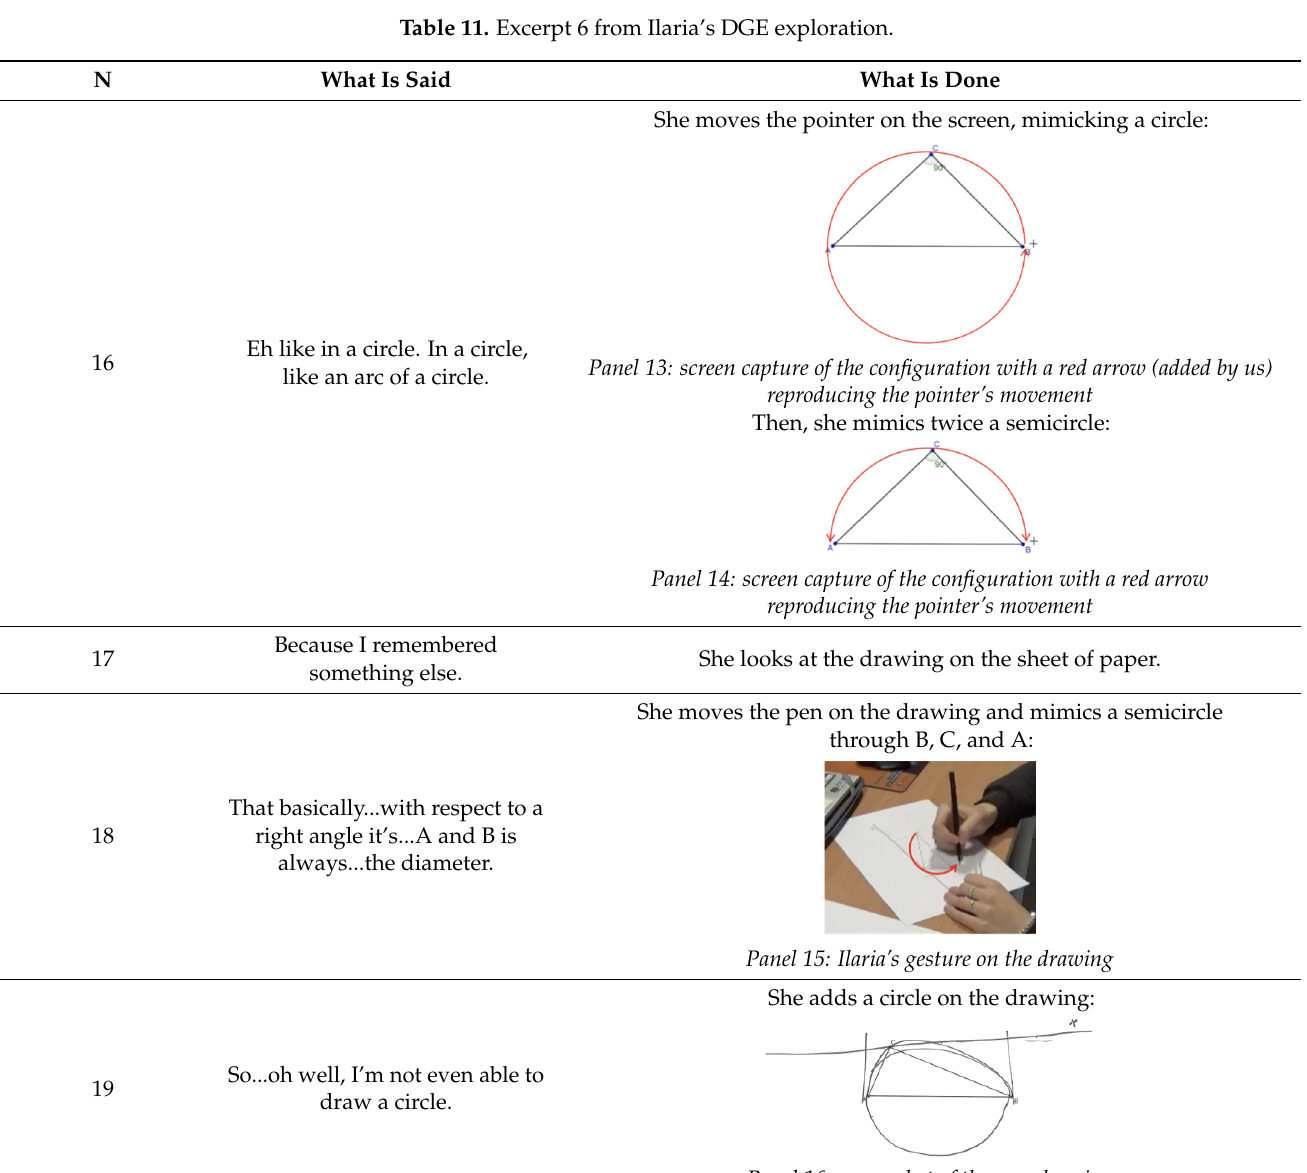
Table 11. Excerpt 6 from Ilaria’s DGE exploration.